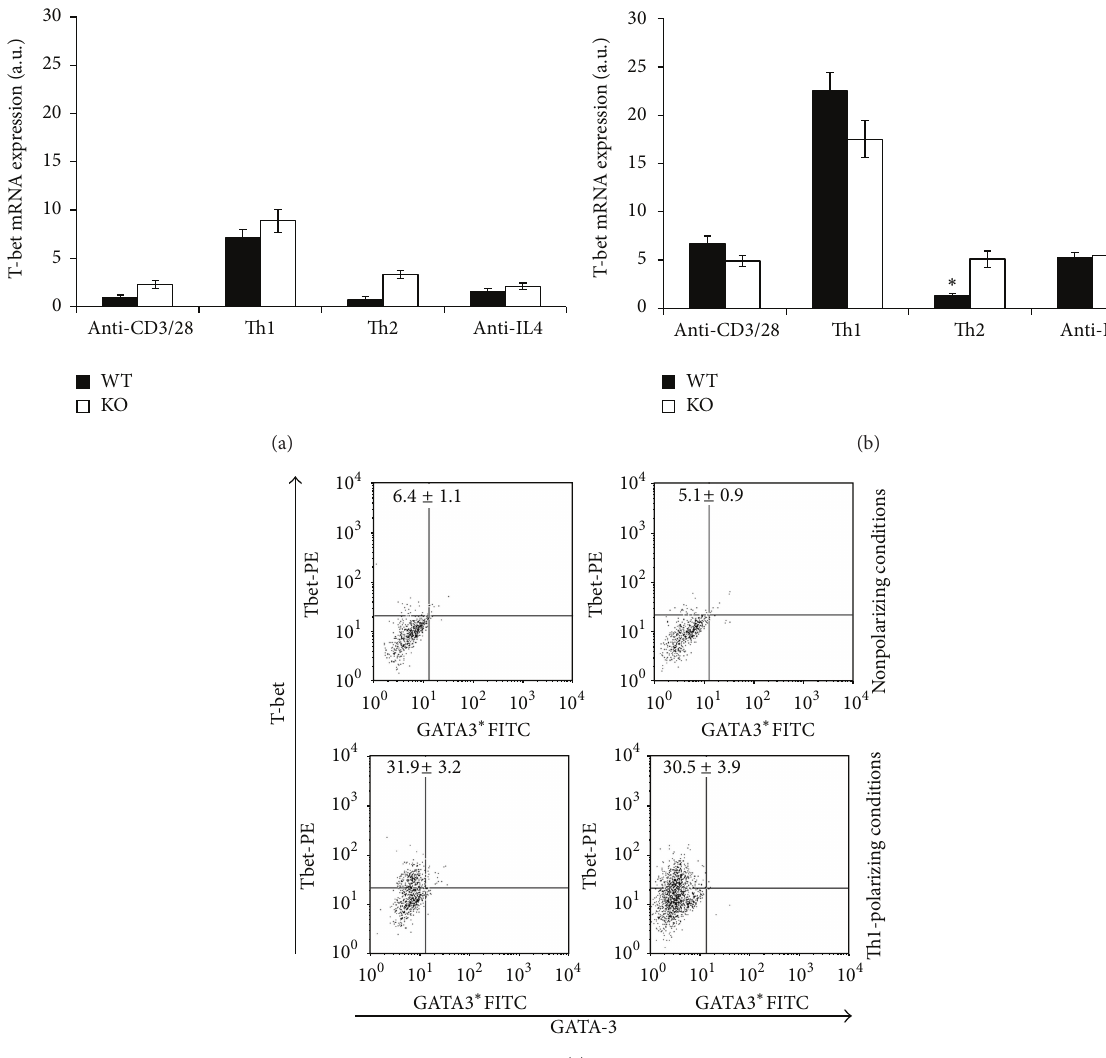
Figure 4: PARP-1 deficiency does not affect T-bet mRNA expression. (a) and (b) Na¨ıve CD4 T cells from wild type (WT, filled symbols) and PARP-1KO (KO, unfilled symbols) mice were stimulated with anti-CD3 and anti-CD28 mAbs alone or together with either IL-12 and neutralizing anti-IL-4 mAb (Th1-polarizing conditions) or IL-4 and a neutralizing anti-IFN- 𝛾 mAb (Th2-polarizing conditions) or anti- IL4 neutralizing mAb (anti-IL4). T-bet mRNA expression was assessed by reverse transcription and real time PCR after 24 (a) and 72 (b) hours of stimulation. Results, normalized on the housekeeping gene (GAPDH) mRNA level, are referred to the T-bet mRNA level in WT cells stimulated for 24hrs and expressed as arbitrary units. Values represent means ± S.E. Results were confirmed in two other independent experiments. (c) After 5 days stimulation with anti-CD3 and rCD86 alone (nonpolarizing conditions, upper panels) or together with IL-12 (and anti-IL-4) (Th1-polarizing conditions, lower panels), cells were analyzed by flow cytometry. Representative dot plots are shown. Numbers in dot plots represent means ( ± S.E.) from three independent experiments. ∗ 𝑃 < 0.05 for KO versus WT